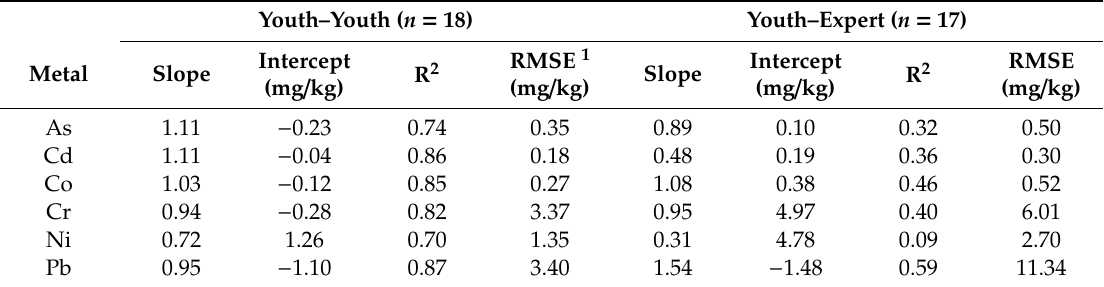
Table 4. Summary measures of linear regressions comparing primary youth moss samples with youth replicates, and primary youth moss samples with expert